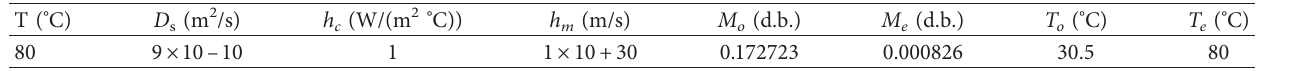
Table 4: Data used in mesh refining study.